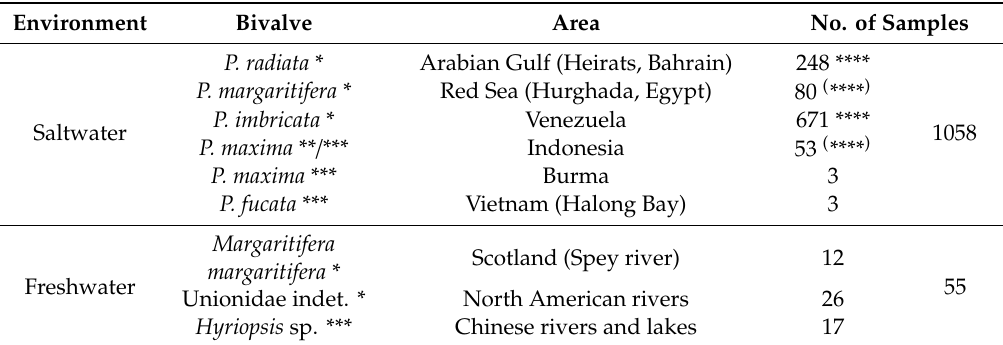
Table 1. List of studied